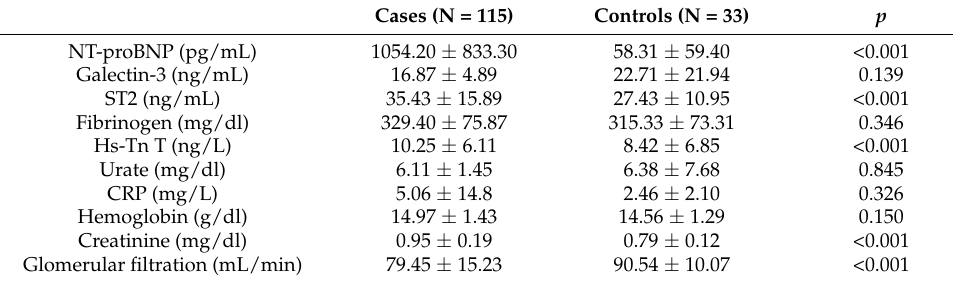
Table 2. Analytical differences between cases and controls.